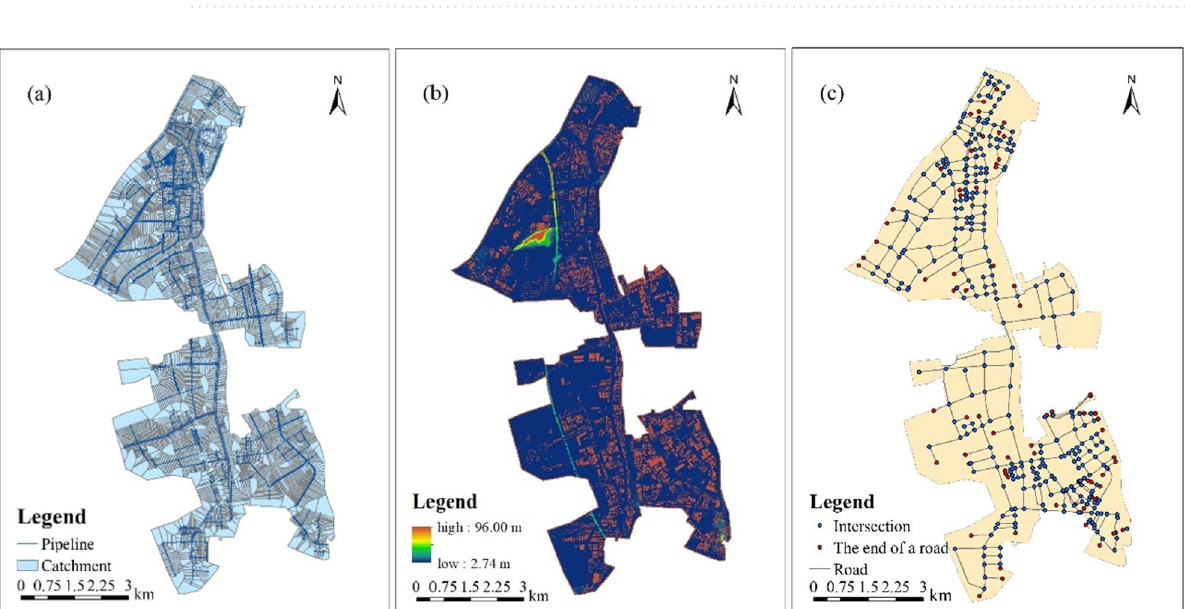
Figure 2. Location of and land uses in the case area. This map was generated with ArcMap Version 10.0. (https:// www. esri. com/ en- us/ arcgis/ produ cts/ arcgis- deskt op/ overv iew).